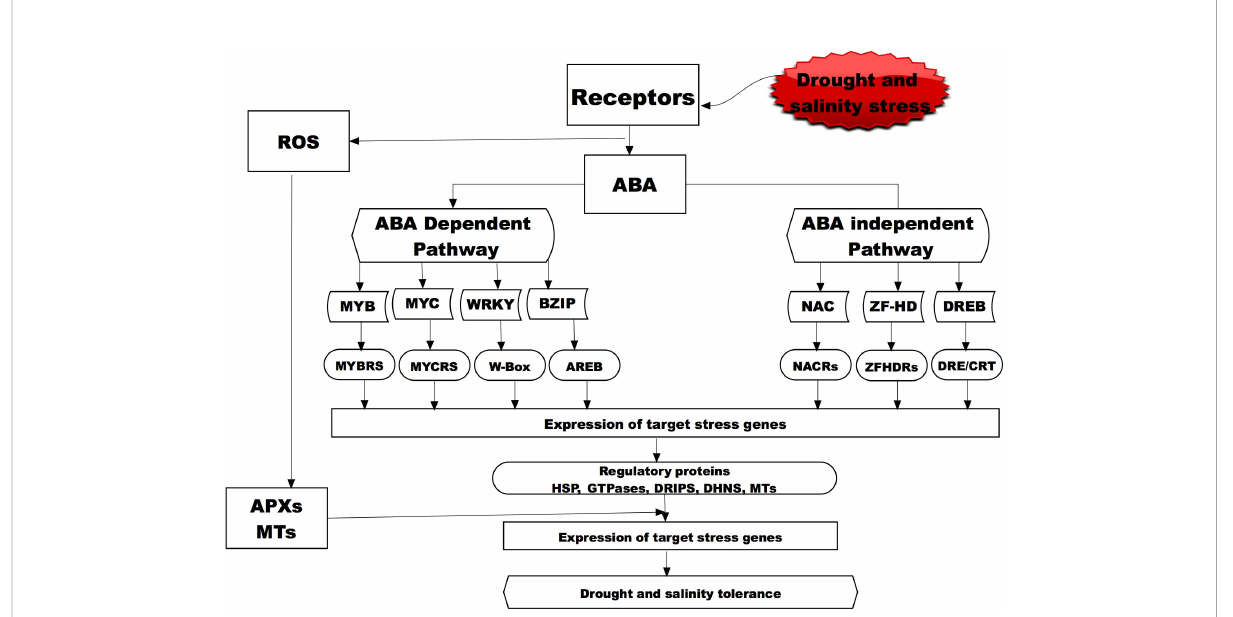
FIGURE 2 A representative diagram showing the molecular signaling for drought and salinity stress in plant through the ABA-dependent and independent pathways. Bolded and broken boxes show the molecular mechanisms that have been studied and presented in this review for the wild water melon drought tolerance and potential salinity tolerance indicators. Abscisic acid, (ABA; Myeloblastosis oncogene, (MYB); Myelocytomatosis oncogene, (MYC); WRKY Basic Leucine Zipper, (BZIP); NAC (NAM, ATAF and CUC) Zinc- fi nger homeodomain, (ZF-HD); Dehydration responsive element binding proteins, (DREB); MYB recognition site, (MYBRs); MYC recognition site, (MYCRs); ABA-responsive element binding protein, (AREB); NAC recognition site, (NARC); ZFHDR, cis-acting element/C-repeat DRE/CRT; Heat shock Proteins, (HSP); Drought induced proteins, (DRIP); ascorbate peroxidase, (APX); metallothionein, (MT); DHN,